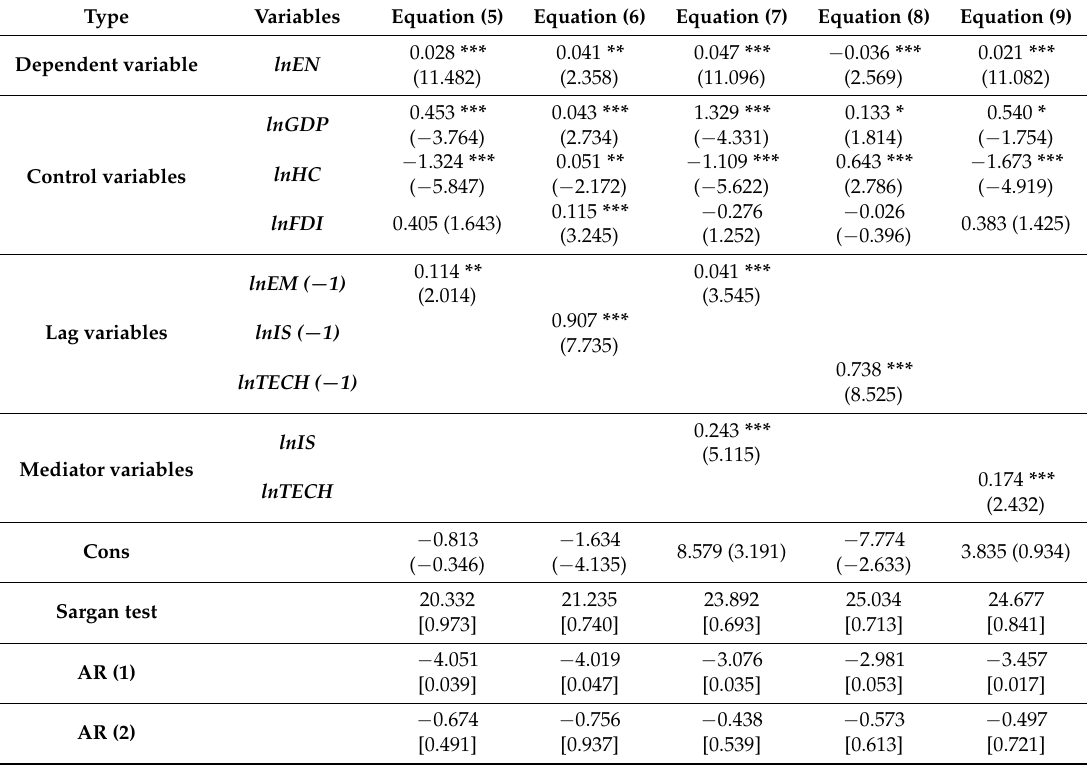
Table 3. Estimation results of the econometric regression